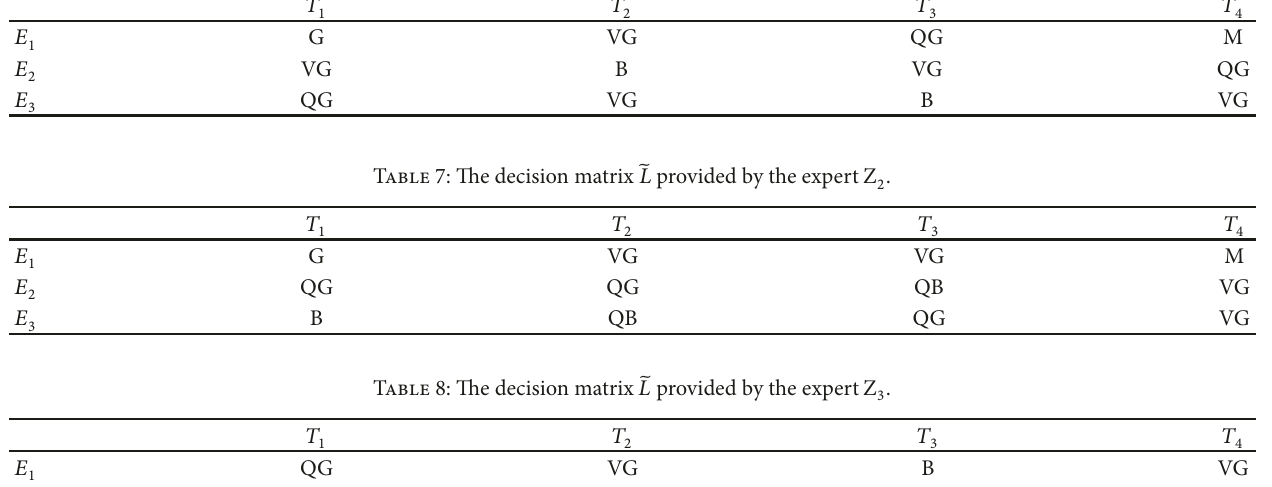
Table 6: The decision matrix